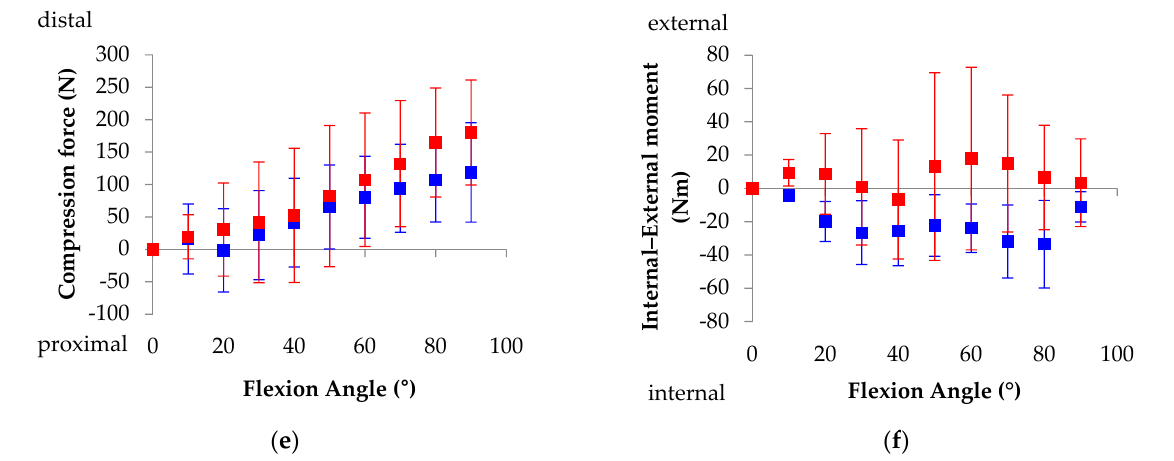
Figure 4. Knee–joint reaction forces and moments in knee joints that underwent total knee arthroplasty (TKA) with/without VM impairment during knee-joint flexion: ( a ) anterior–posterior reaction force (Fx); ( b ) varus–valgus moment (Tx); ( c ) medial–lateral reaction force (Fy); ( d ) flexion–extension moment (Ty); ( e ) proximal–distal reaction force (Fz); ( f ) internal– external moment (Tz).